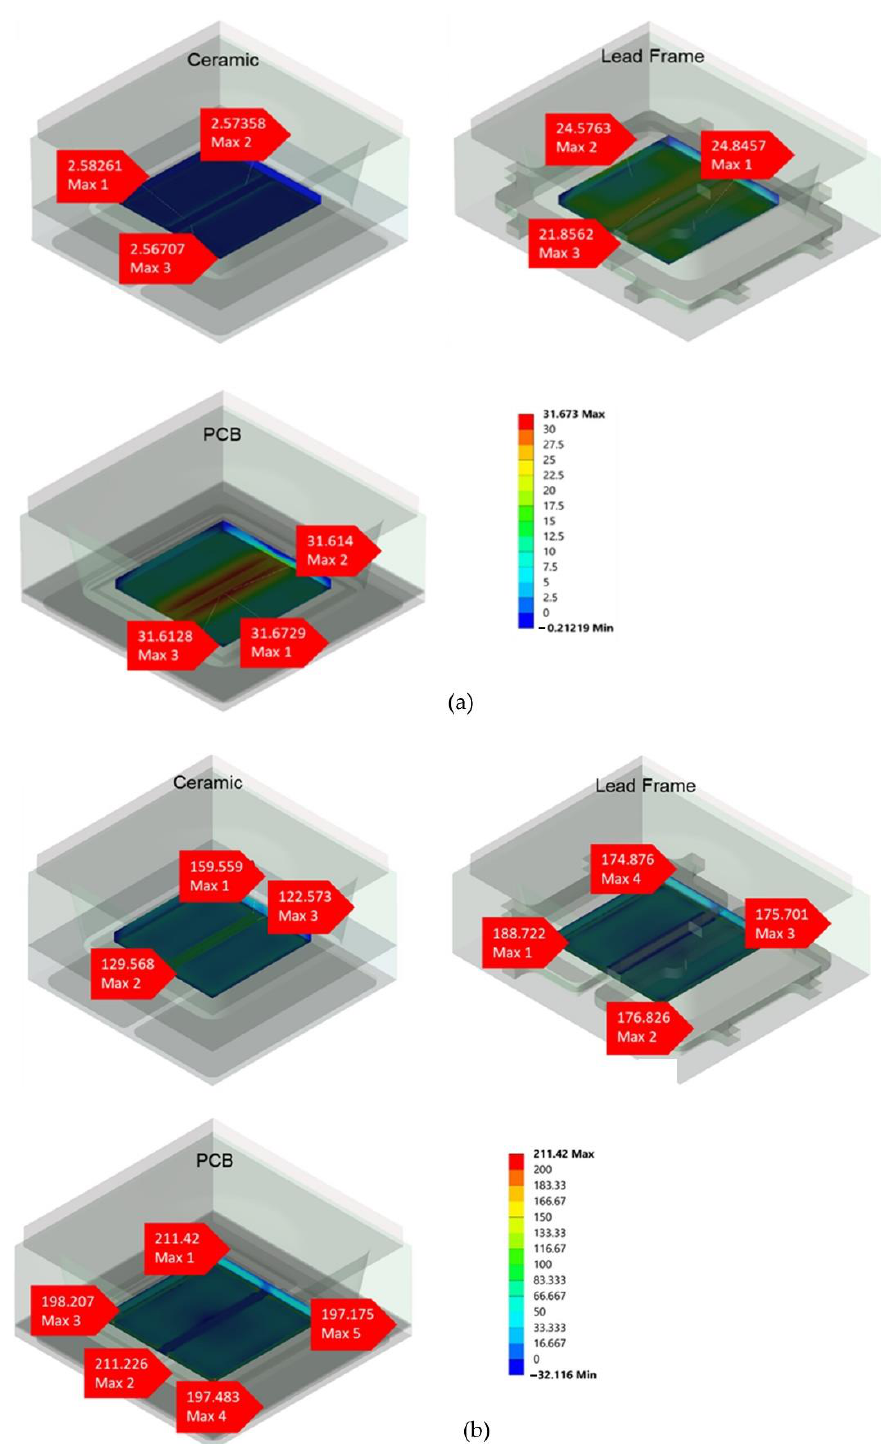
Figure 10. The 3D image of the stress value at the chip surface area for three types of VCSEL packages during mechanical stress simulation at ( a ) high temperature of 260 °C and ( b ) low temperature of − 40 °C.